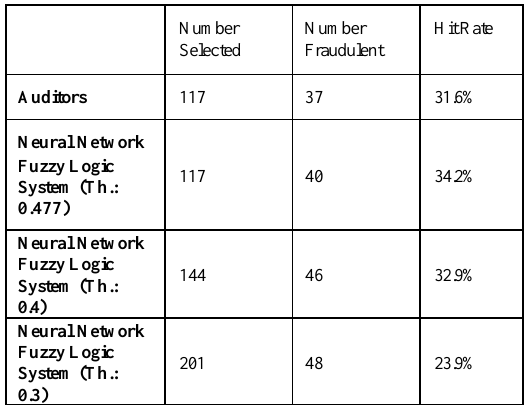
Table 1: Comparison of number of fraudulent claims detected Lowering the review threshold for the NN Fuzzy Logic system to 0.4 will select 144 cases for review.